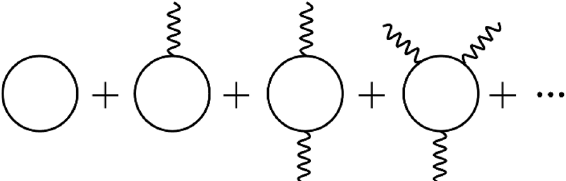
Figure 5 . The Feynman diagram of Schwinger effect. In order to calculate the Schwinger pair production, one should sum the infinite set of diagrams, each of which contains one electron loop and any number of external photon